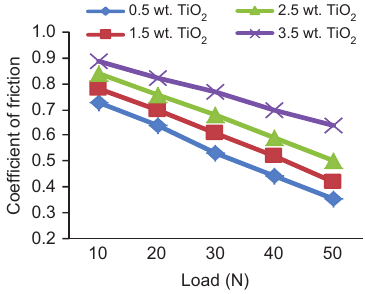
Figure 7 Coefficient of friction with increasing load in the compos- ites developed by the addition of TiO commercial aluminum, without debris removal. Full-size image (41